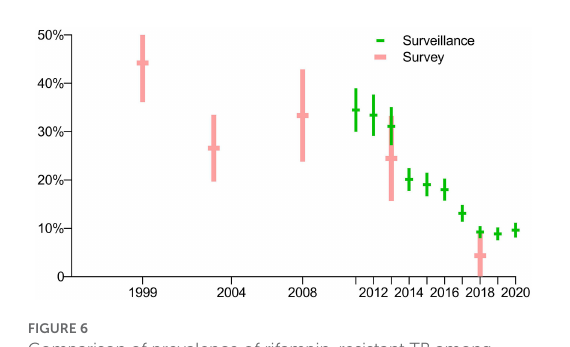
FIGURE4 Prevalence of pre-extensively drug-resistant TB: breakdown by treatment history in five periodic surveys.